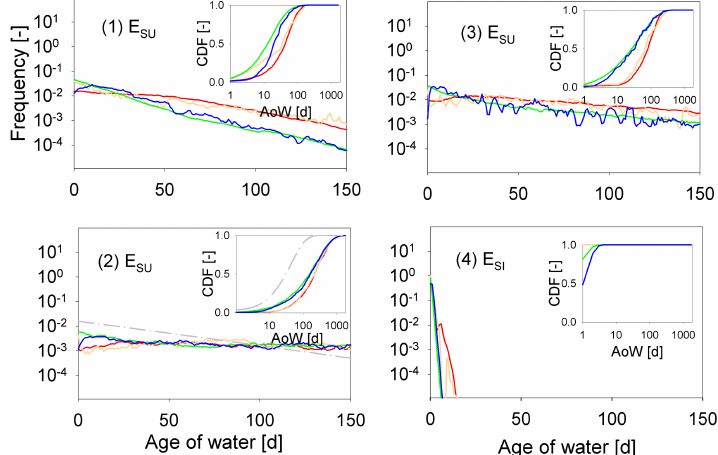
Fig. 7. Temporally averaged, unweighted flux water age distributions p F for all evaporative processes in the three study catchments (1 – Allt Coir nan Con, 2 – Allt a’Mharcaidh and 3, 4 – Burn 11) for the four pre-defined hydrological regimes. The averages were constructed from the median water ages for all time steps within the respective hydrological regime. The figures show the full results of the PM scenarios and only where significant differences were found, the temporally averaged, unweighted results of the CM scenario constructed from the median of all values for the entire time series is given (grey, dash-dotted line) in addition. The color code of the lines is corresponding to the four hydrologic regimes defined in Fig. 5: red (dry), yellow (wetting-up), green (wet) and blue